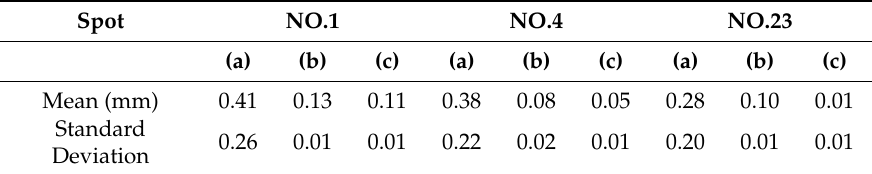
Figure 15. The curve of the Euclidean distance between the ideal spot position and the calculation spot position with di ff erent conditions. Table 2. Comparison between di ff erent calibration: (a) uncalibrated data, (b) the data with static voltage deduction calibration, (c) the data with static voltage deduction and equalization gain calibration. Spot